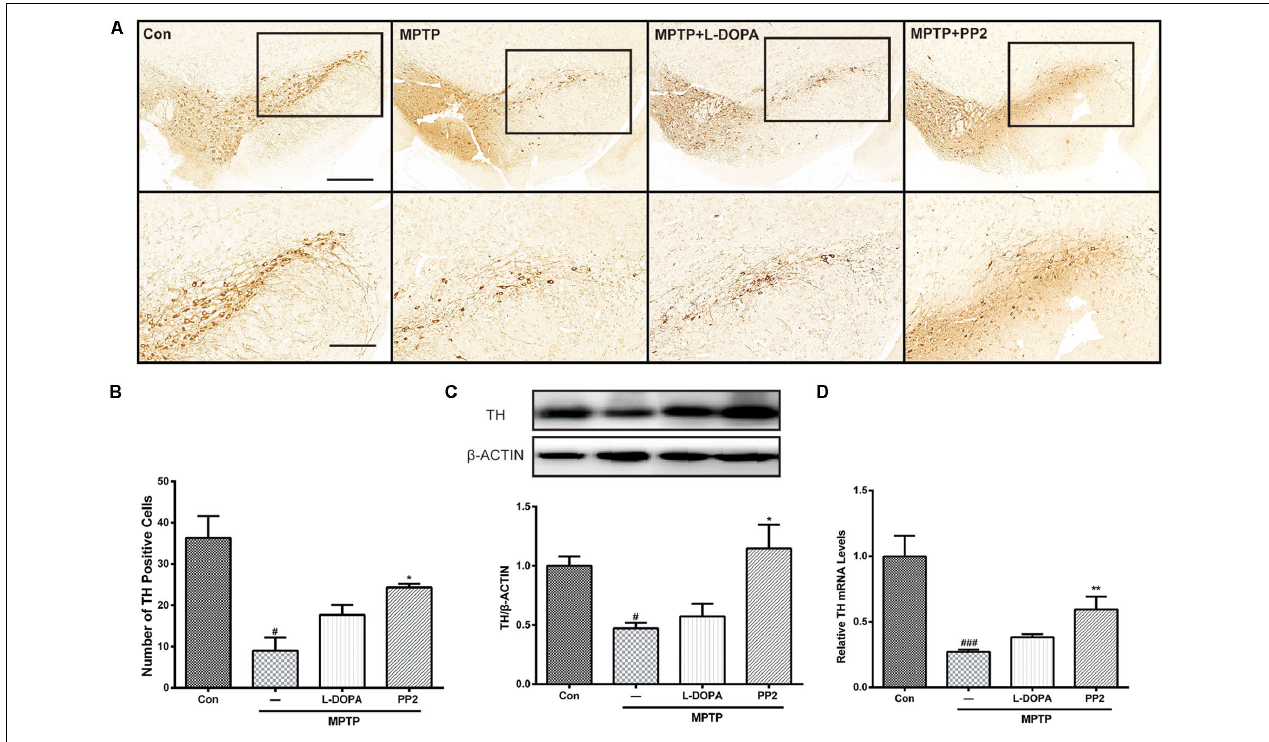
FIGURE 6 | Src inhibition enhanced the survival of dopaminergic neurons of the 1-methyl-4-phenyl-1,2,3,6-tetrahydropyridine (MPTP)-treated mice. (A) Representative images showed tyrosine hydroxylase (TH)-immunoreactive neurons in the SNpc (scale bar: top, 500 µ m; bottom, 250 µ m). (B) The number of TH-positive neurons per slide in SNpc was counted for each section and provided in a histogram. Data are expressed as means ± SEM. n = 4. # P < 0.05 vs. control group,* P < 0.05 vs. lipopolysaccharide (LPS) group. (C) The protein expression level of TH in SNpc of MPTP-treated mice was analyzed by western blot. Data are expressed as means ± SEM. n = 4. # P < 0.05 vs. control group,* P < 0.05 vs. LPS group. (D) The mRNA expression level of TH in SNpc of MPTP-treated mice was determined by quantitative reverse transcription (qRT)-PCR. Data are expressed as means ± SEM. n = 4. ### P < 0.001 vs. control group, * P < 0.05 vs. MPTP